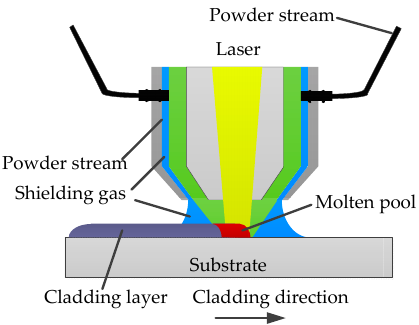
Figure 1. Laser cladding process schematic.